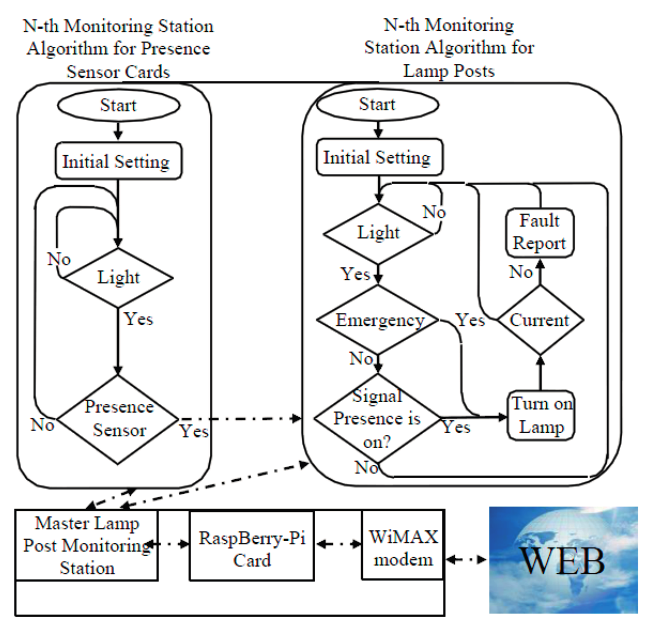
Figure 3. Management strategy of the Smart